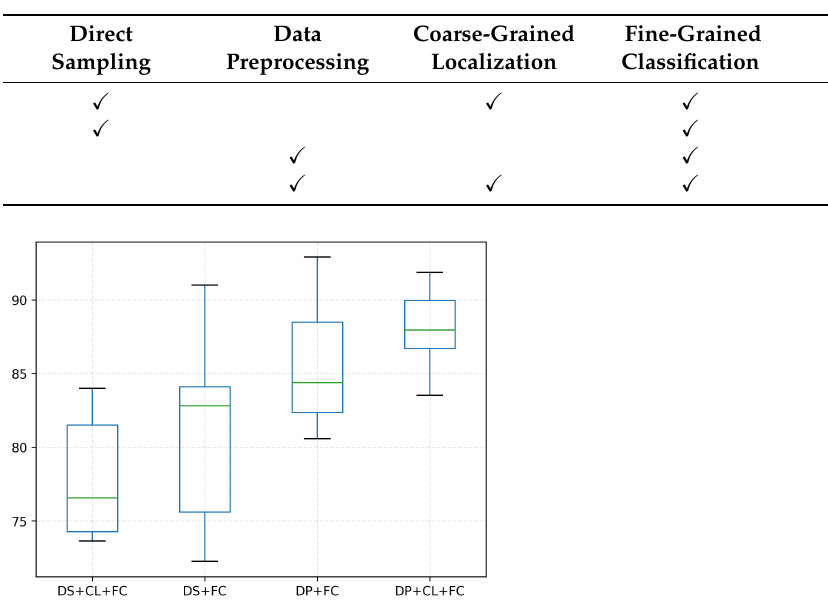
Figure 9. The boxplot of the dispersion of ten-fold cross-validation ablation experimental results. The short form is used to facilitate reading: DS refers to Direct Sampling, DP refers to Data Preprocessing, CL refers to Coarse-grained Localization, FC refers to Fine-grained